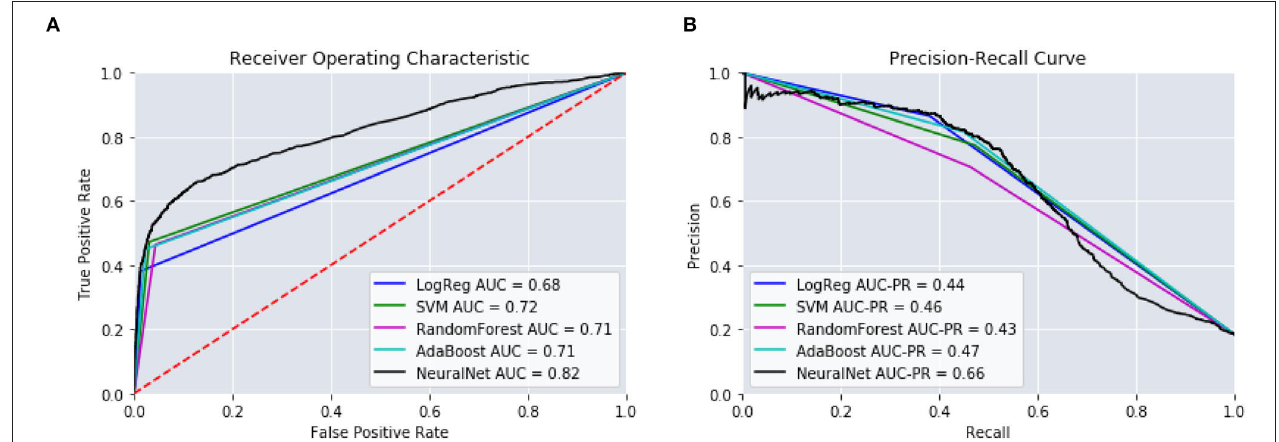
FIGURE 6 | Performance of the predictive models using [14 : 90]. (A) ROC Curves. (B) Precision-Recall